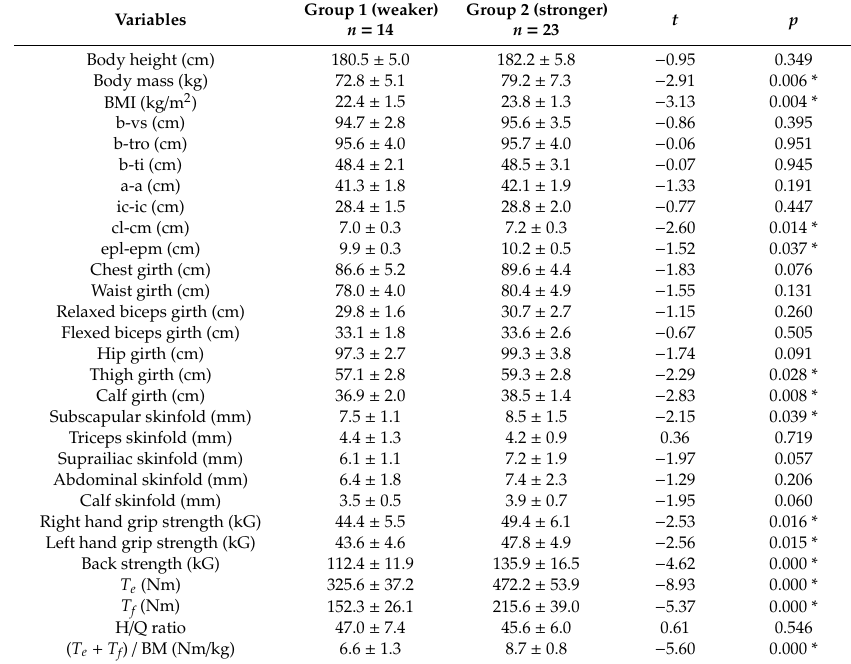
Table 2. Statistical characteristics of the variables studied in separate